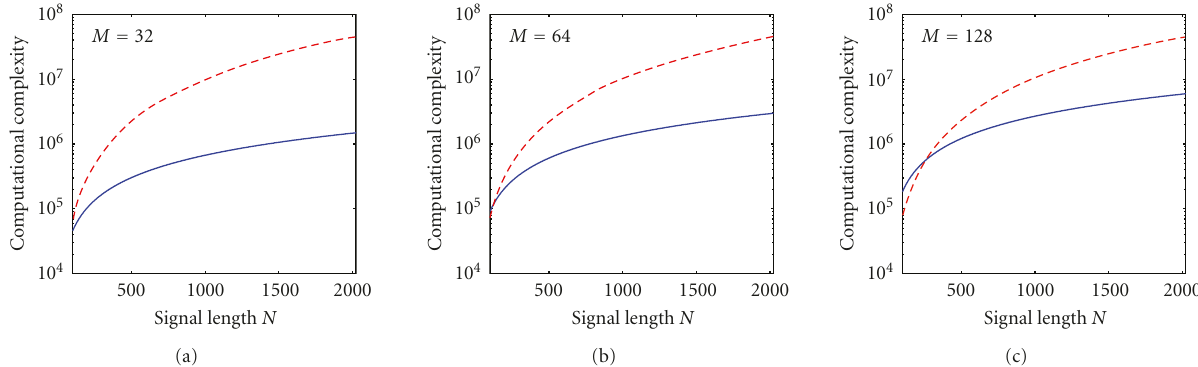
Figure 1: The computational complexity of the two methods. Dashed line: the modulus square detector. Solid line: the new